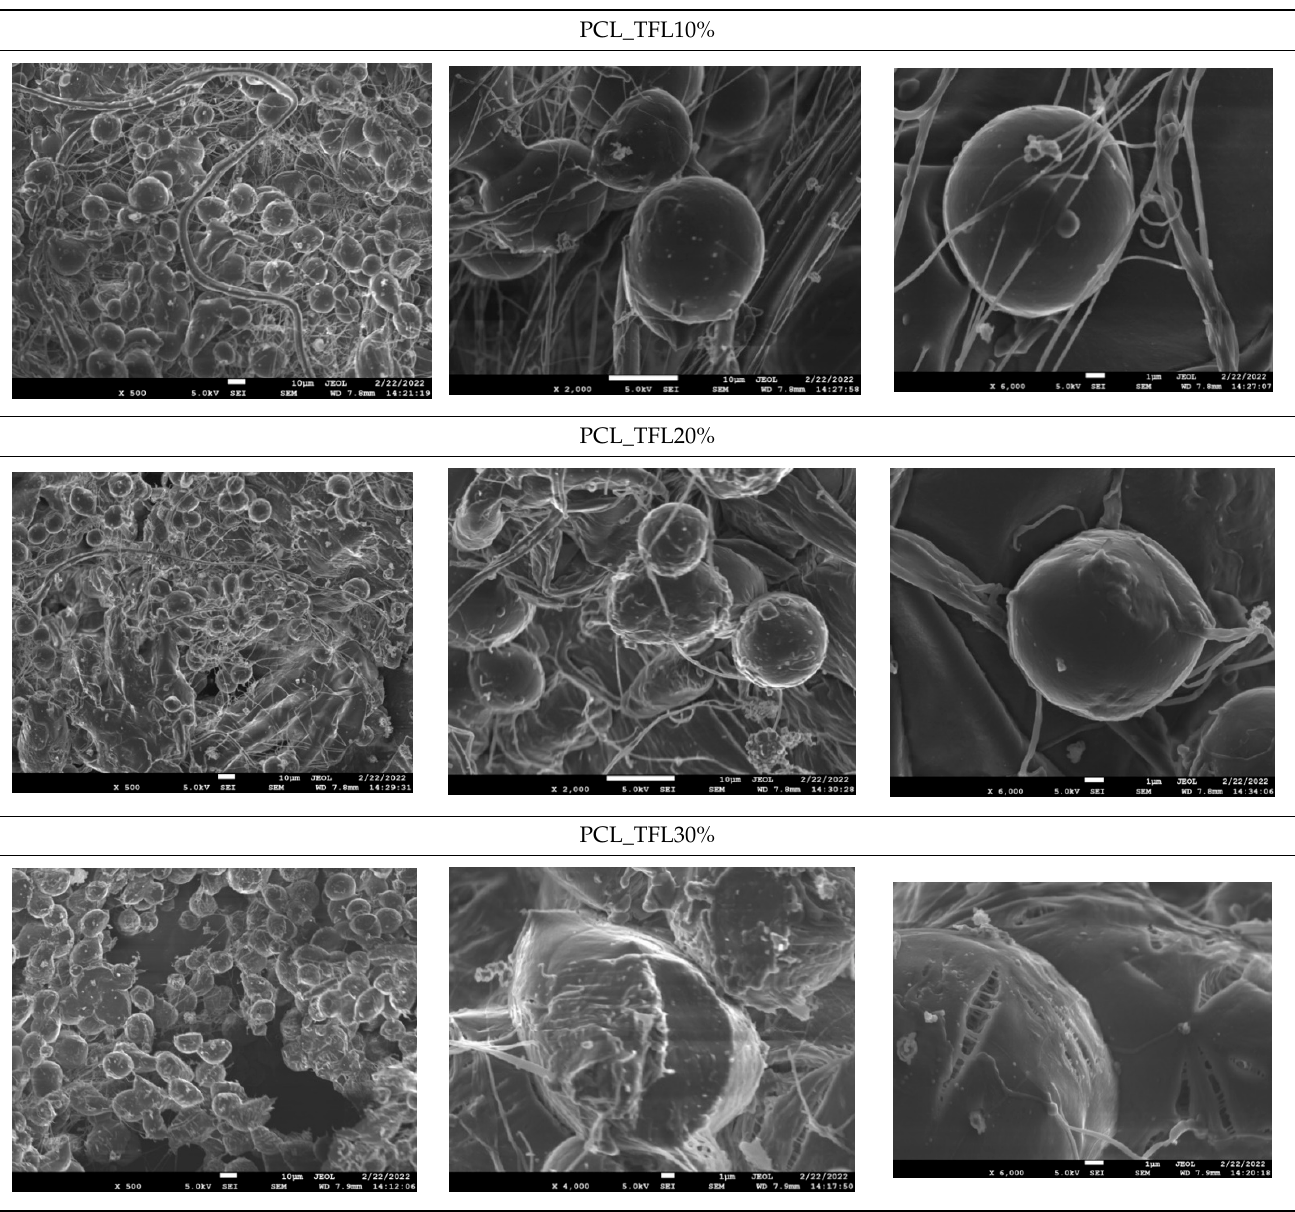
Table 8. SEM images at different magnifications of PCL/TFL fibrous mats after in vitro drug dissolu- tion for the investigation of release mechanism.